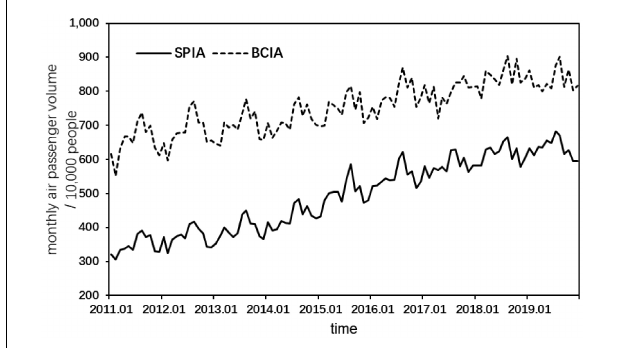
FIGURE 4 | Air passenger volume of two airports from January 2011 to December 2019.